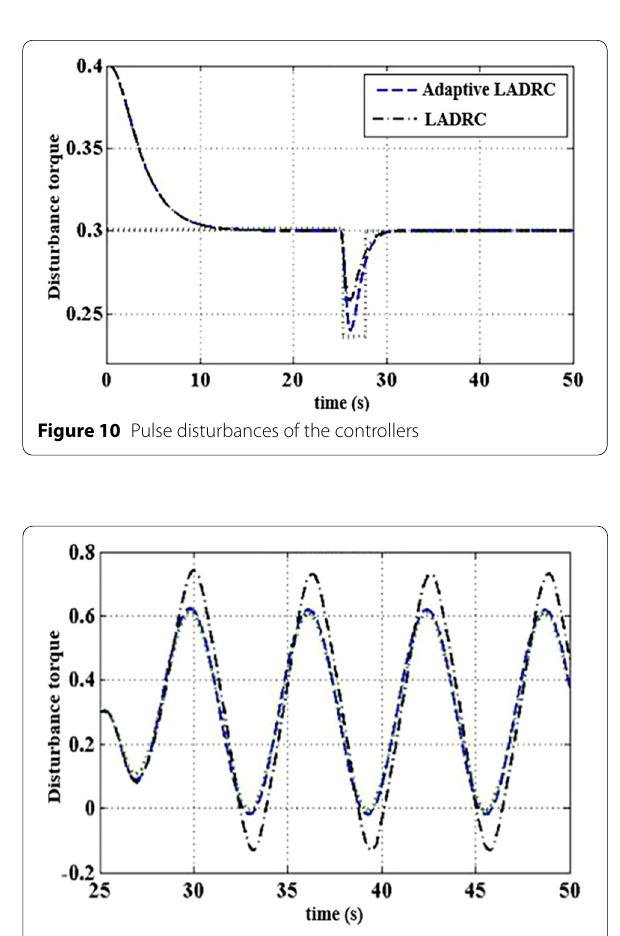
Figure 11 Sinusoidal disturbances of the